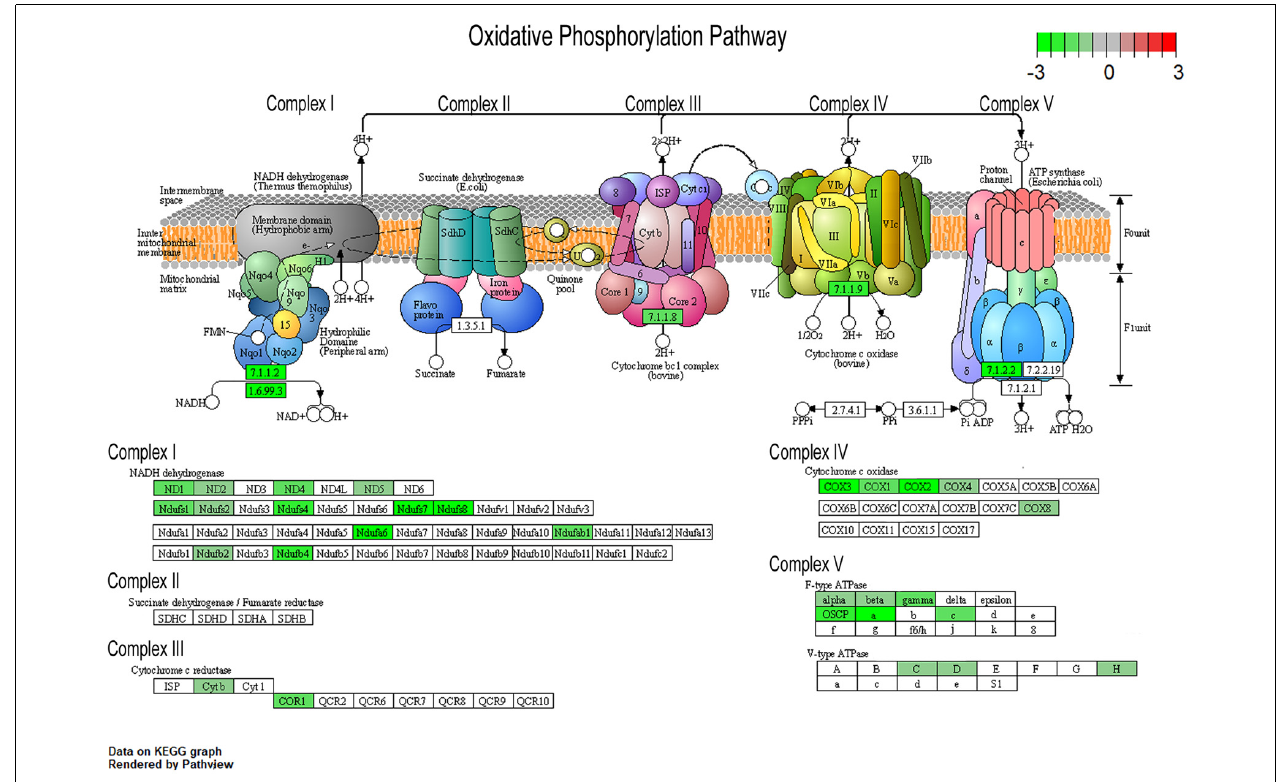
FIGURE 1 | Pronounced downregulation of members of the oxidative phosphorylation pathway in trisomic basal forebrain cholinergic neurons (BFCNs). The Kyoto Encyclopedia of Genes and Genomes (KEGG) derived oxidative phosphorylation pathway is rendered by Pathview, with significantly dysregulated genes highlighted for each complex from the medial septal nucleus (MSN) BFCNs as assayed by single population RNA-seq (Alldred et al., 2021). Downregulation is shown as color coded log fold change difference (LFC) with green depicting downregulation and red depicting upregulation. Note no genes within the oxidative phosphorylation pathway were